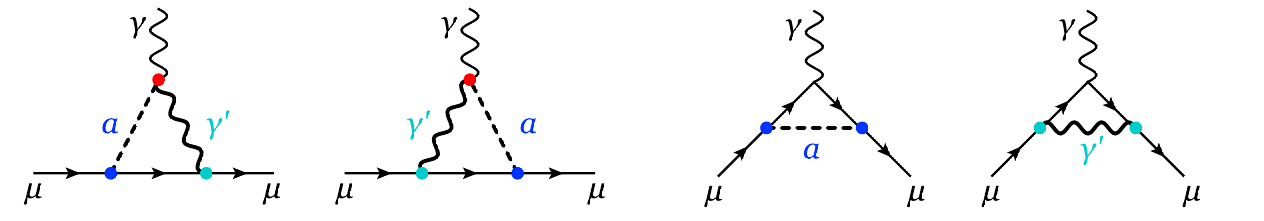
Fig. 2 The ALP (left) and dark photon (right) contributions to the muon anomalous magnetic moment